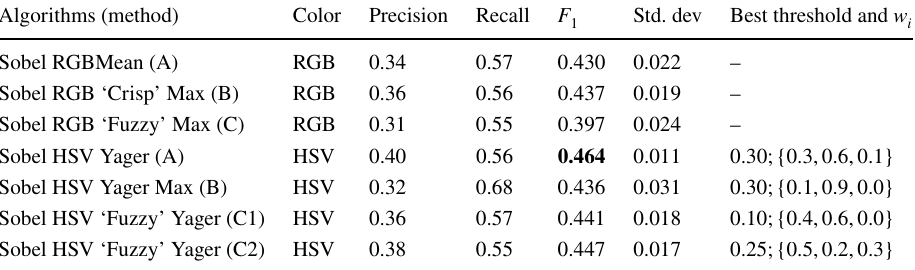
Bold value indicate method reached the highest